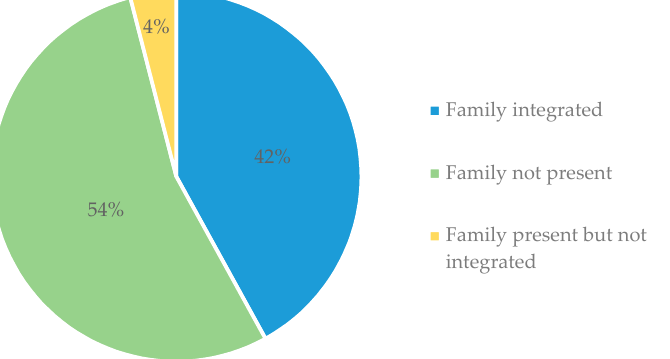
Figure 2. Family integration in patients’ tobacco use treatment (TUT), N =